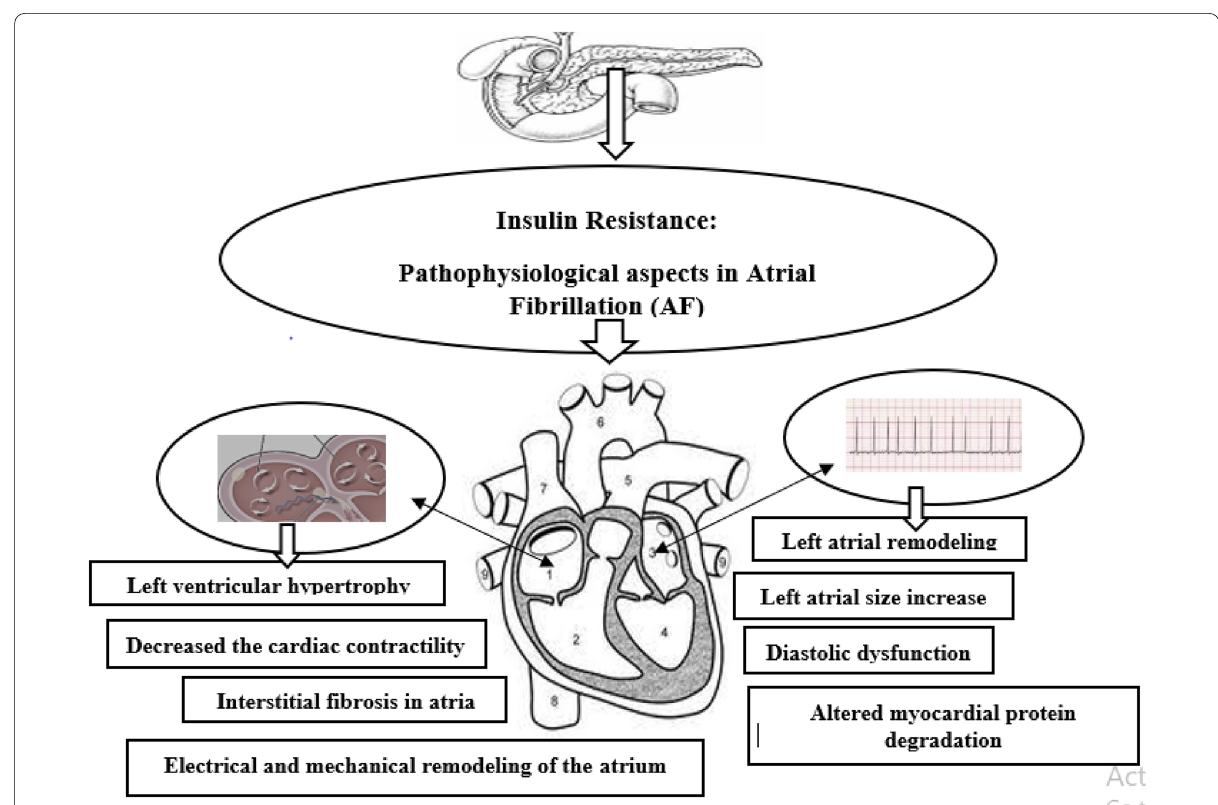
Fig. 2 Summary of pathophysiological aspects of insulin resistance in AF. Source: Designed by the author with the help of review